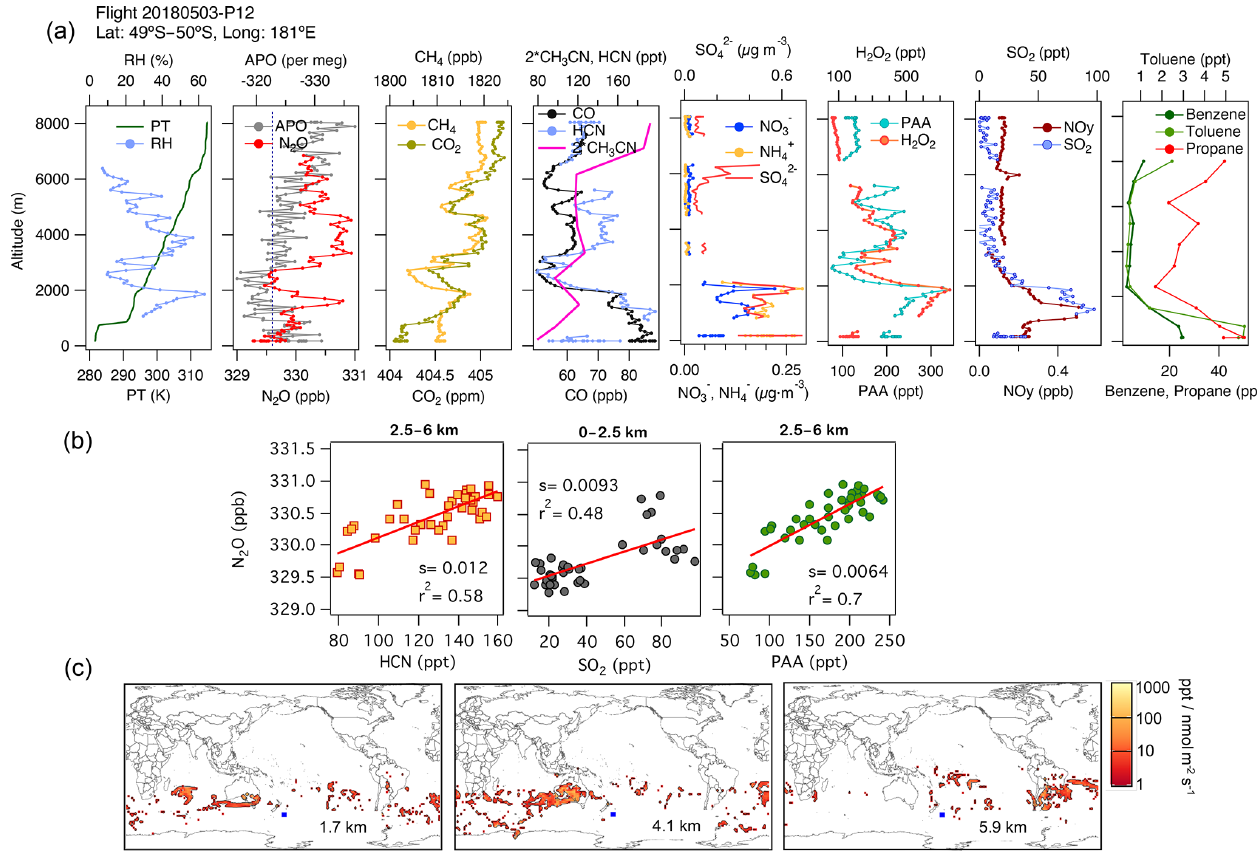
Figure 5. (a) Vertical profiles of potential temperature (PT), relative humidity (RH), N 2 O, APO, CH 4 , CO 2 , CO, HCN, CH 3 CN, NO − SO 2 + , H 2 O 2 , PAA (CH 3 C(O)OOH), SO 2 , NO y , benzene, toluene, and propane from profile 12, obtained on 3 May 2018. The dotted blue 4 line in the plot of APO and N 2 O represents the NOAA-MBL reference (N 2 O-MBL) at the latitude of the flight. (b) Correlations between N 2 O and HCN and PAA for altitudes between 2.5 and 6km, and between N 2 O and SO 2 for altitudes between 0 and 2.5km, indicate an admixture of marine, biomass-burning, urban, and oil and gas industry contributions to N 2 O mixing ratios ( s represents the slope of the linear fit). (c) Footprint maps tracing surface regions that influence mixing ratios measured at the altitude ranges of 1–2, 2.5–5, and 5–7km, respectively. Blue squares show sampling locations. Values below 3pptnmol − 1 m 2 s are not included. Note that the APO axes are